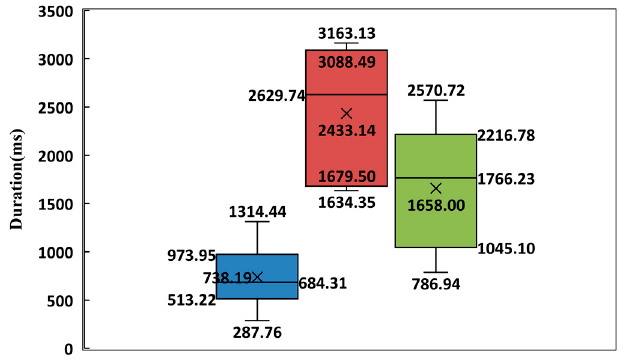
Figure 7. Statistical graph of the duration of the initial stage. The blue part corresponds to the single initial process form, the red part corresponds to the multiple initial process form and the green part corresponds to first initial process in the multiple initial process form.